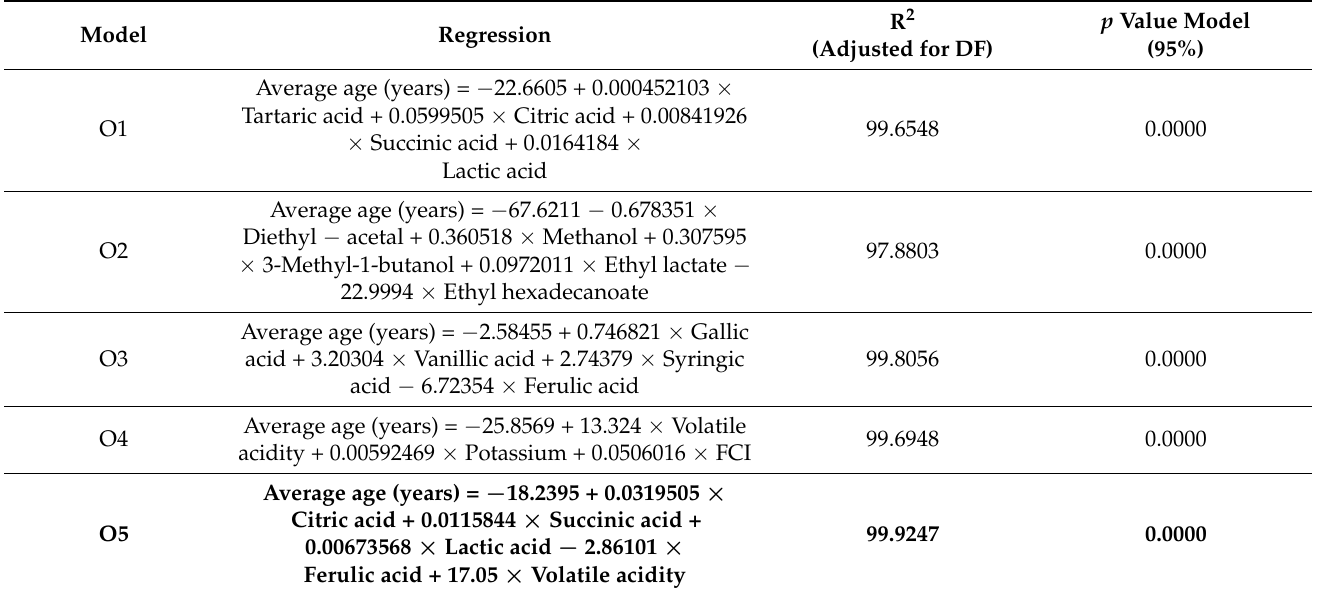
Table 11. Regression models (MLR) to estimate the ageing of Oloroso Sherry wines. O1: glycerol and organic acids model; O2: polyphenols model; O3: volatile compounds model; O4: “other variables” model; O5: overall